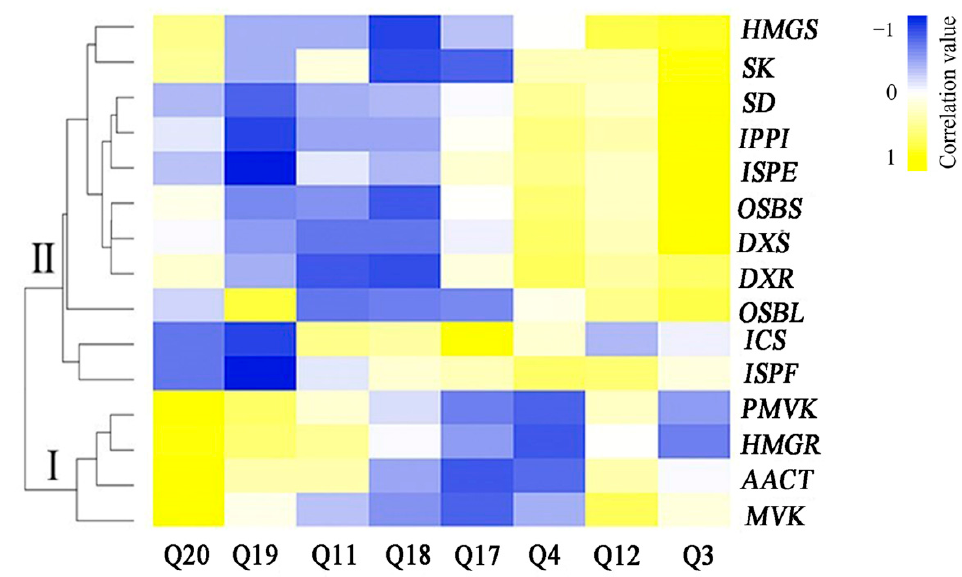
Figure 5. Pearson correlation for the expression levels of 15 genes and the contents of six anthraquinones and two naphthoquinones. Heatmaps were generated using Heatmapper (http://www.heatmapper.ca/expression/, accessed on 25 May 2021).